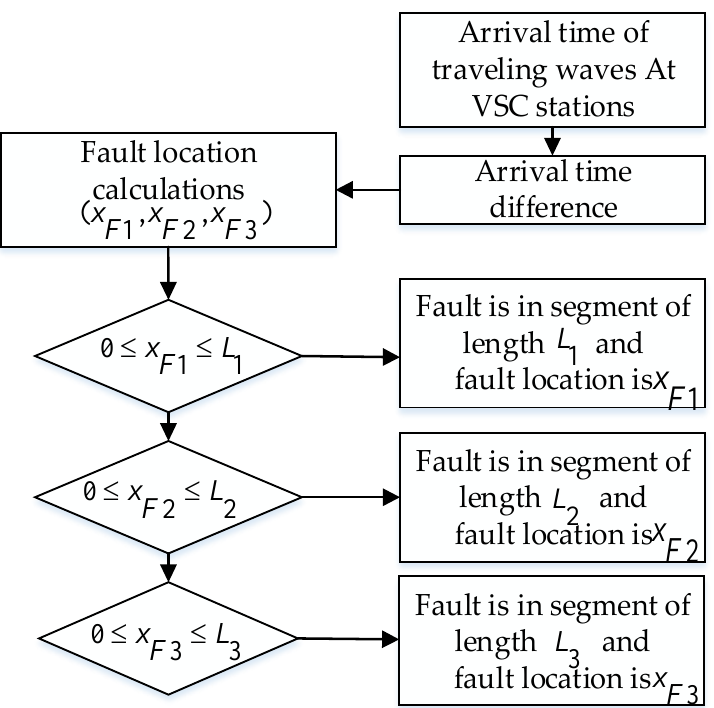
Figure 5. Faulty segment identification algorithm.